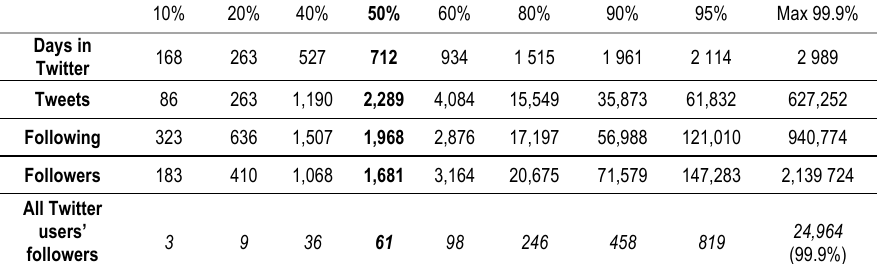
Table 6. Key characteristics of the Twitter users that followed the analysed case accounts in the API